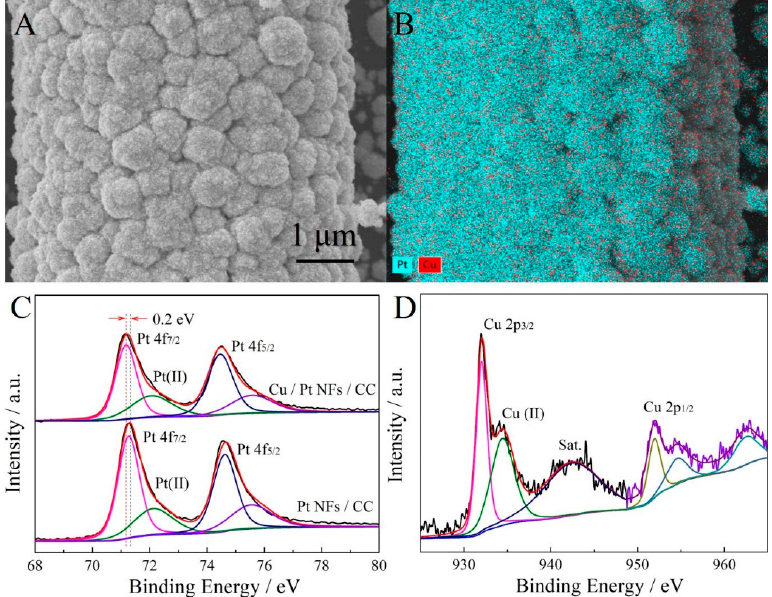
Figure 2. SEM image ( A ) and the corresponding elemental mapping image ( B ) of Cu / Pt NFs / CC, the blue and red colors in ( B ) correspond to Pt and Cu elements, respectively; Pt 4f XPS spectra ( C ) of Pt NFs / CC and Cu / Pt NFs / CC, Cu 2p XPS spectra ( D ) of Cu / Pt NFs /